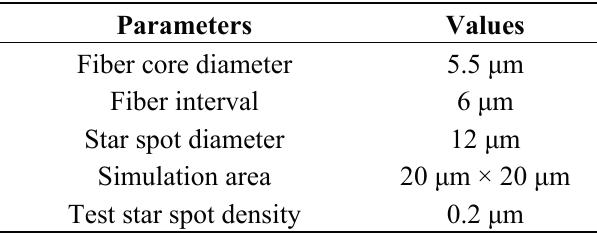
Table 1. Simulation parameter